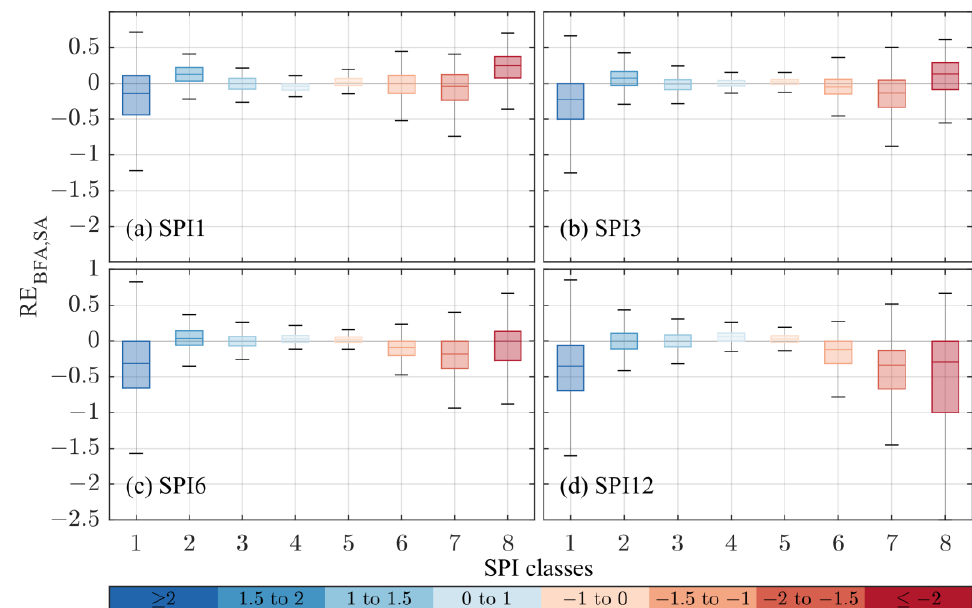
Figure 3. Box plots representing the Relative Error (RE) of the number of classes detected by the SPI estimated with the BFA and SA. The horizontal zeros grey line represents the perfect match between the two approaches. Both the wet (blue-shades) and dry (red-shades) categories are depicted. The SPI classes (from 1 to 8) are ordered from the extremely wet to the extremely drought categories, according to Table 1.